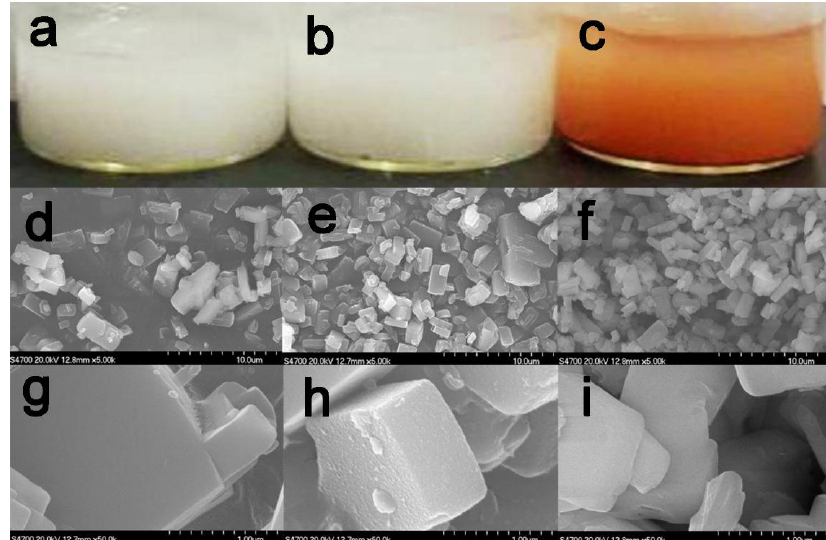
Figure 2. Images of three silicalite-1-based materials. The color appearances of activated silicalite-1 ( a ); APS-silicalite-1 ( b ); and GA-APS-silicalite-1 ( c ); the SEM image of activated silicalite-1 ( d ); APS-silicalite-1 ( e ); and GA-APS-silicalite-1 ( f ) with scale bar of 10 um; the SEM image of activated silicalite-1 ( g ); APS-silicalite-1 ( h ); and GA -APS-silicalite-1 ( i ) with scale bar of 1 um. Table 1. Trehalose yield of first two recycling batches using slilicalite-1, APS-silicalite-1, and GA-APS- silicalite-1 as support.